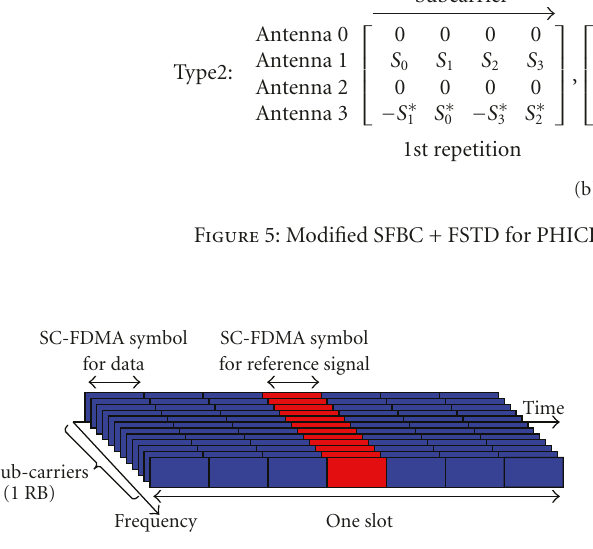
Figure 6: Multiplexing of data and reference signal on uplink.